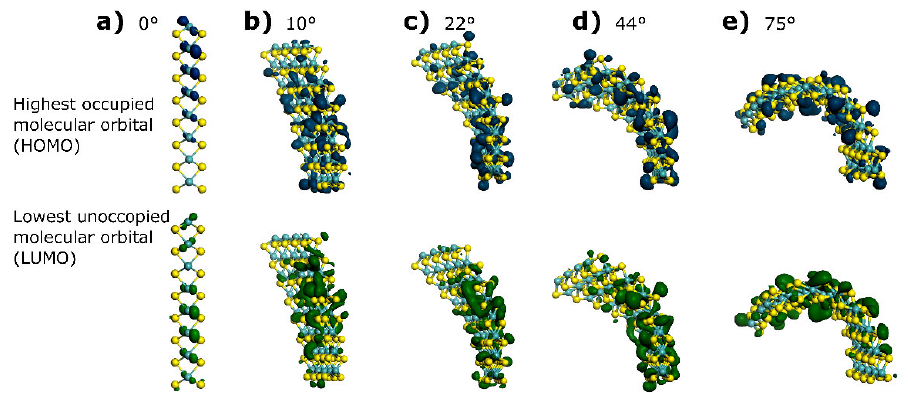
Figure 2 . Energy isosurfaces for HOMO (dark blue isosurface) and LUMO (dark green isosurface) computed for theoretical models as a function of slab bending, isosurface value is 0.03. Cyan balls represent the position of molybdenum and yellow balls represent sulfur. It is possible to determine that bending effects provoke changes in the 2H ‐ MoS 2 conventional electronic structure, which has been highly discussed in the literature, ( a ) Represents the HOMO ‐ LUMO distribution for 0° angle 2H ‐ MoS 2 layer, one can observed not much delocalized electrons clouds. ( b – e ) The 2H ‐ MoS 2 layers are bend from 10° to 75° and it was possible to detect a perturbation of HOMO ‐ LUMO energy states by delocalized electron clouds.